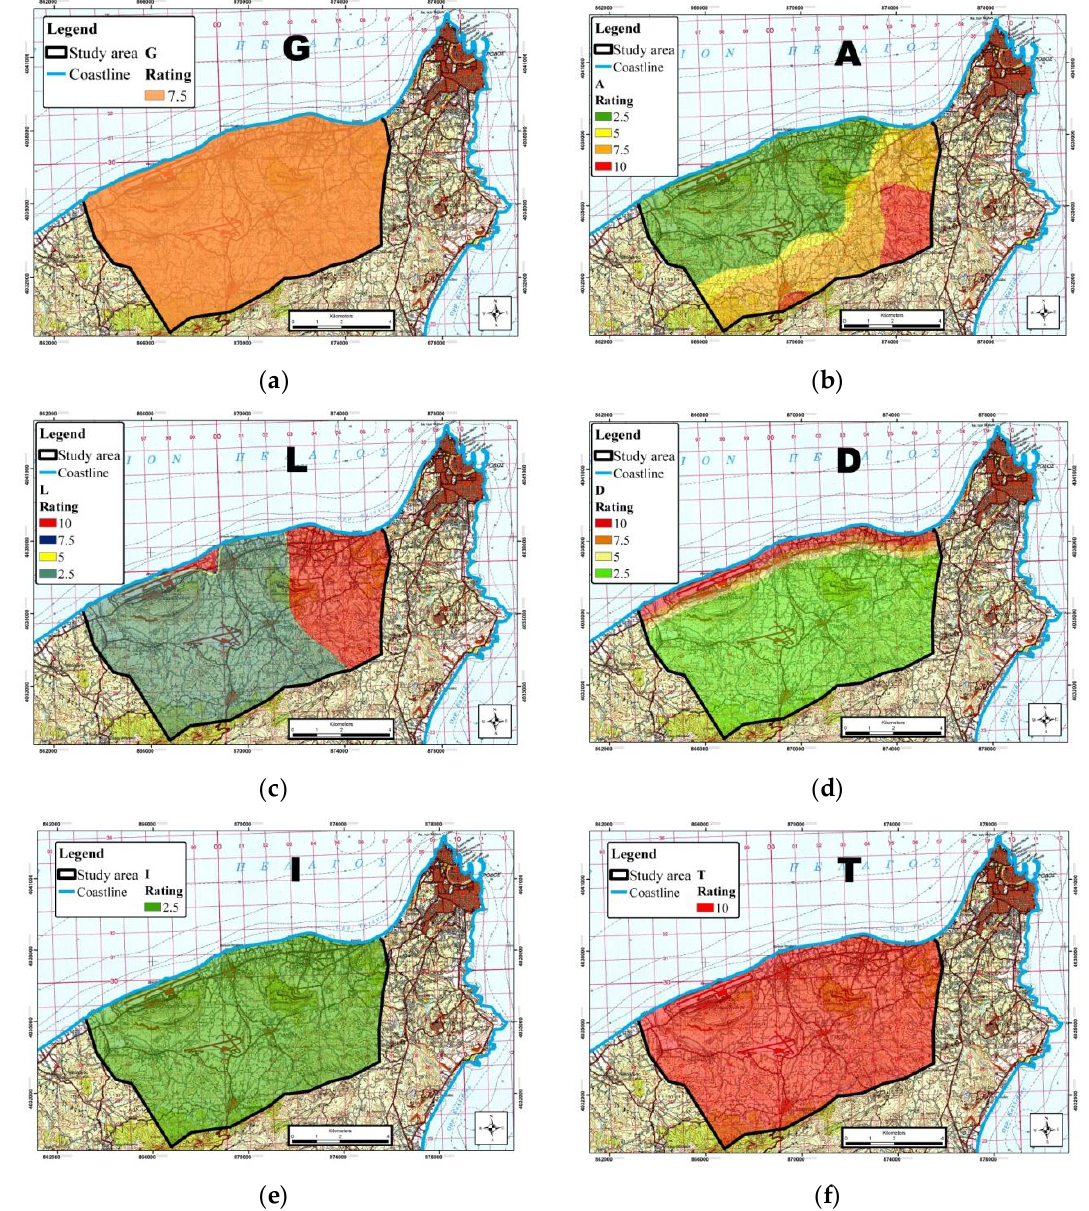
Figure 2. Thematic maps of GALDIT method parameters: ( a ) Thematic map of parameter G, ( b ) thematic map of parameter A, ( c ) thematic map of parameter L, ( d ) thematic map of parameter D, ( e ) thematic map of parameter I, and ( f ) thematic map of parameter T.